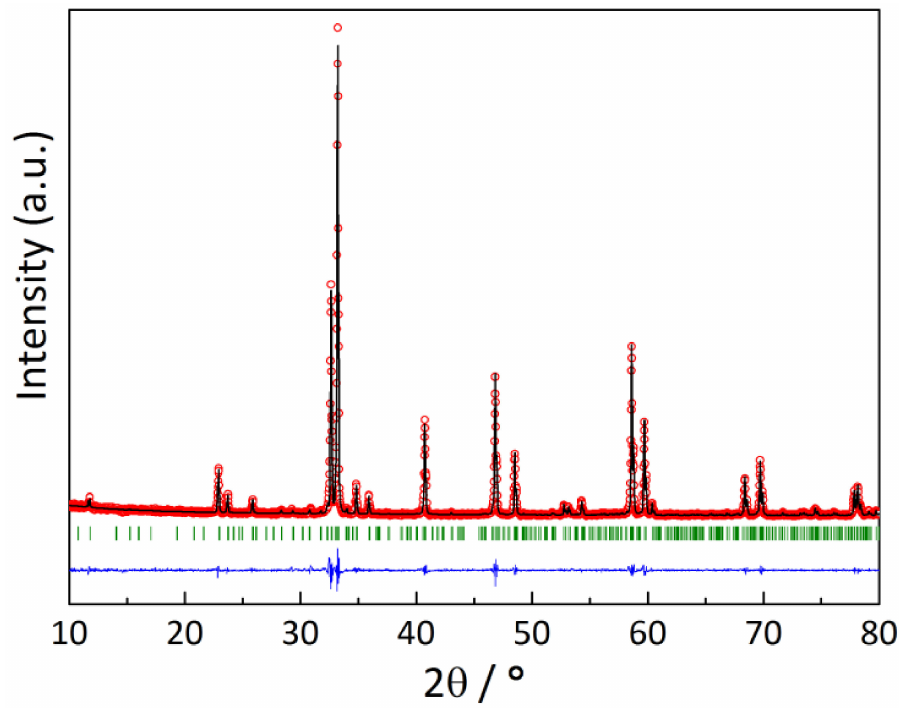
Figure 1. The XRD pattern of the YBaCo 2 O 5.33 sample: red circles—experimental data, black line—calculated pattern, blue line—difference between the experimental and calculated data, green dashes—positions of the allowed Bragg